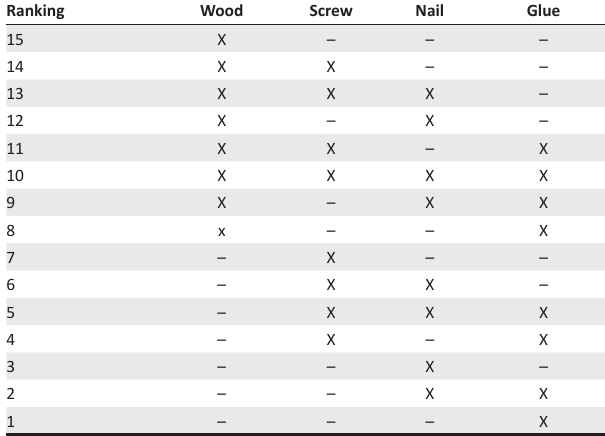
TABLE 1-A1: Ranking of assembly